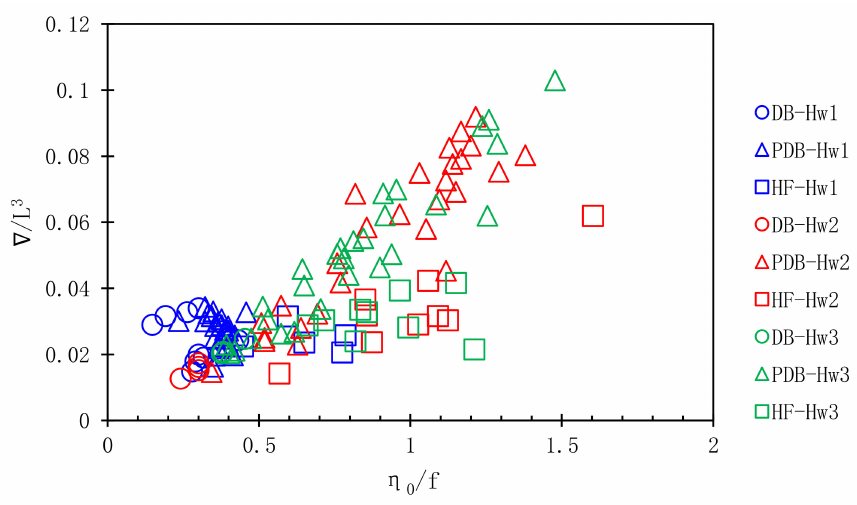
Figure 14. Relation between the non-dimensional freeboard exceedance ( η 0 / f ) and the non- dimensional maximum volumes ( ∇ * = ∇ / L 3 ) in the green water events of all the study cases.